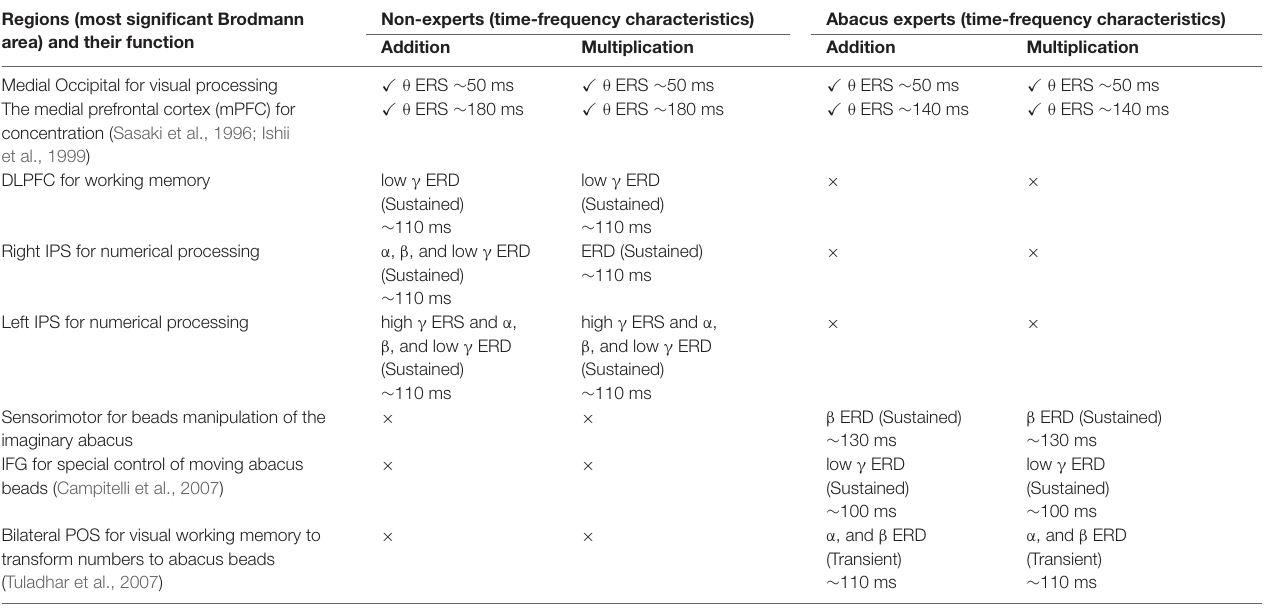
TABLE 1 | Similarities and differences of brain activity during mental operation tasks as revealed by conjoint analysis across subjects in each group for the proposed model of calculation processing. Regions (most significant Brodmann area) and their